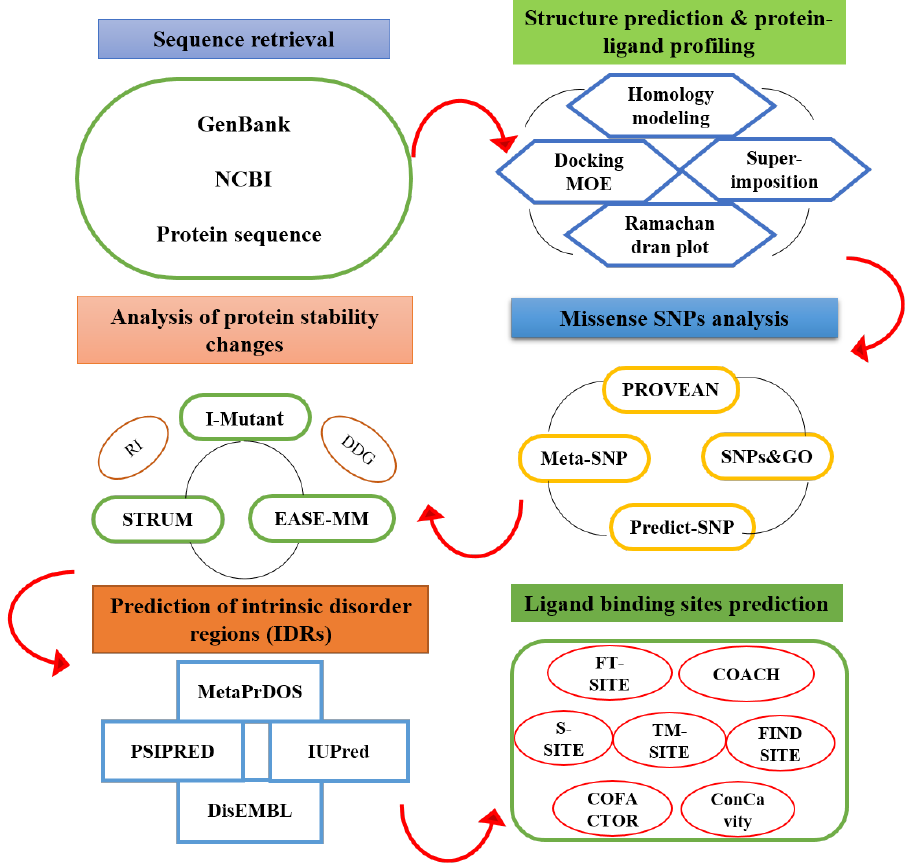
Figure 1. Schematic representation of designed study to find drug binding sites of poliovirus 2A protease along with missense single-nucleotide polymorphisms (SNPs). MOE: Molecular Operating Environment, RI: Reliability Index DDG: Free Energy change value.